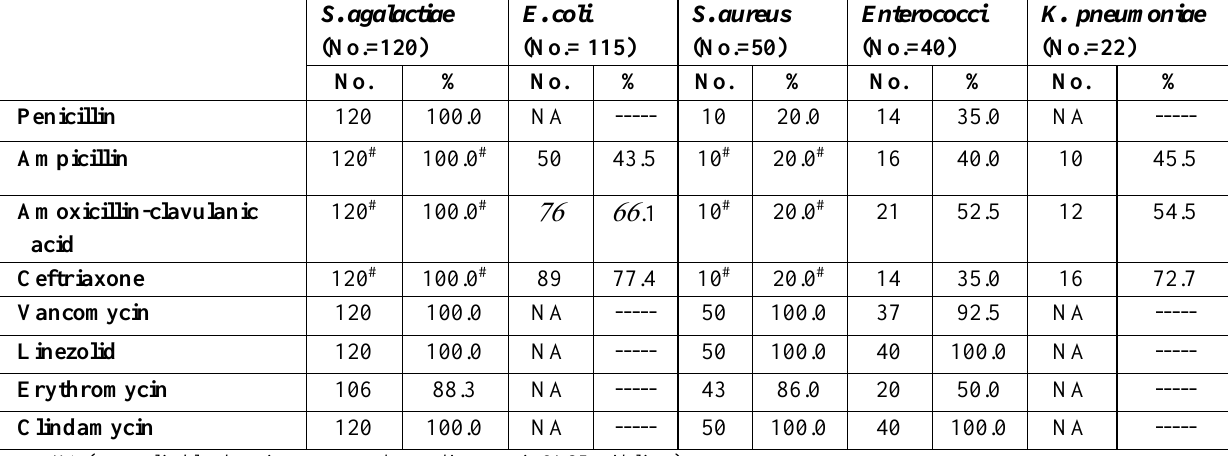
Table 4. Antimicrobial susceptibility of isolated bacteria.